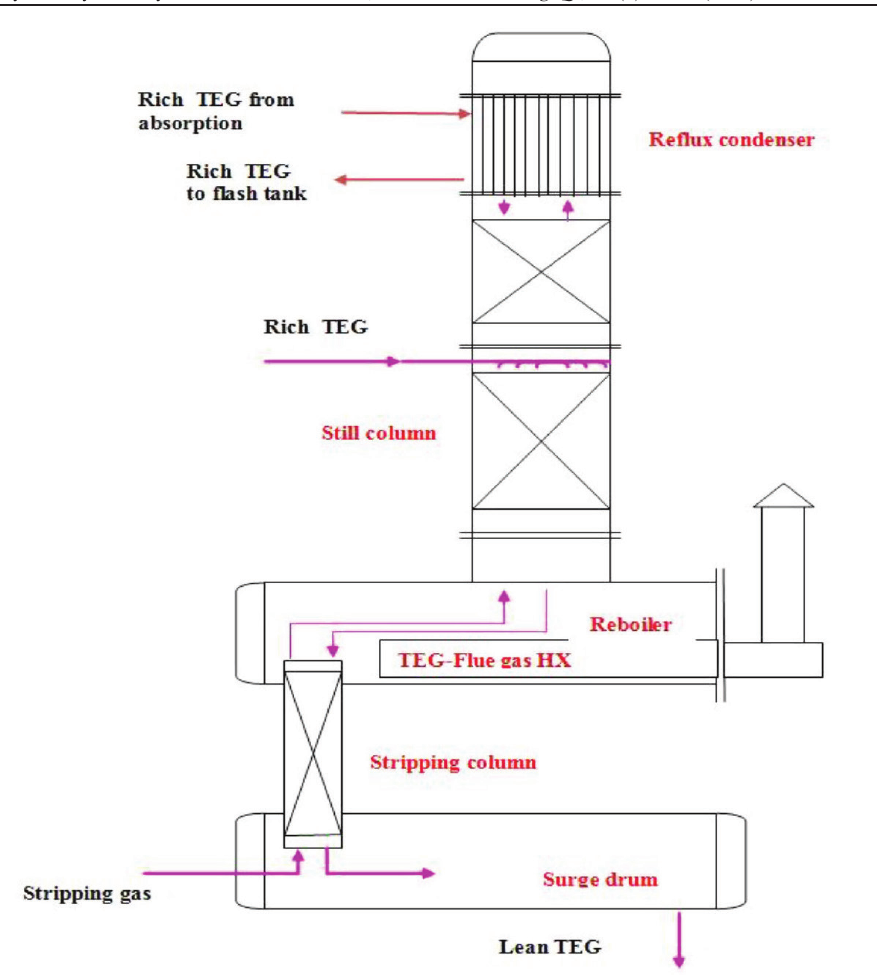
Fig. 2 – Regeneration: Increased TEG purity using the stripping